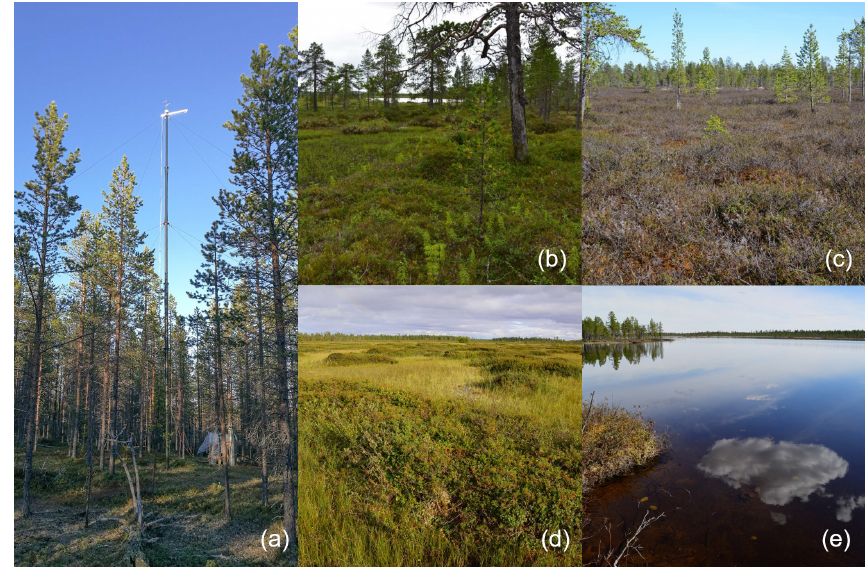
Figure 2. The main ecosystem types within the study area are a (a) Scots pine forest, (b) treed pine bog, (c) sparsely treed pine bog, (d) fen, and (e) lake. Photo credits: (a) Lauri Heiskanen and (b–e) Tarmo Virtanen.